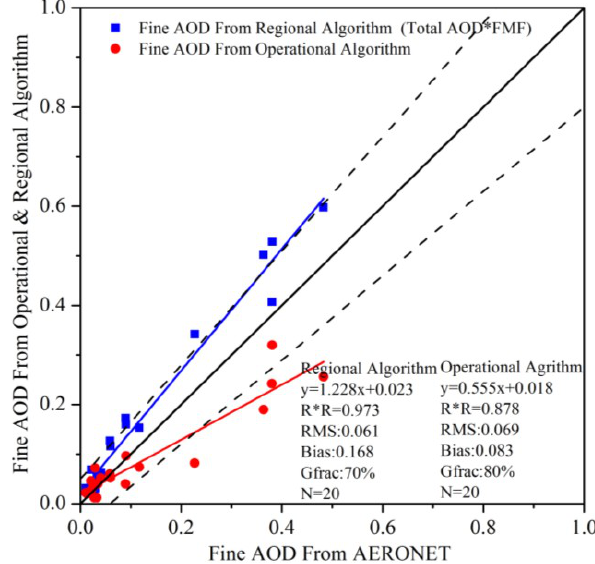
Fig.8. Comparison of Fine AOD retrieved present algorithm with those of operational algorithm at Beijing from September to December in 2010.